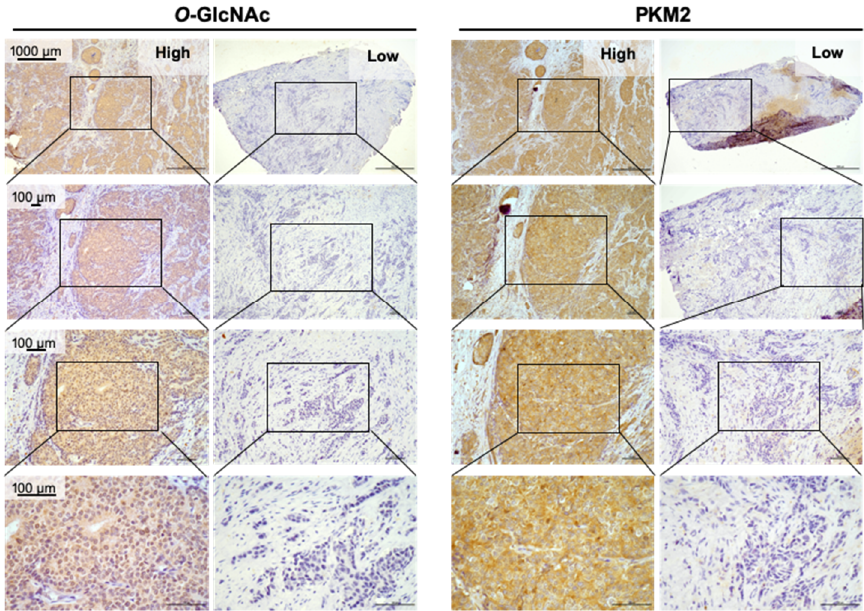
Figure 4. Representative images of IHC profiles. O -GlcNAc and PKM2 were immunostained for each of the BC specimens ( n = 162). Low, Q ≤ mean; High, Q > mean. The images are enlarged in series (box, the enlarged portions).